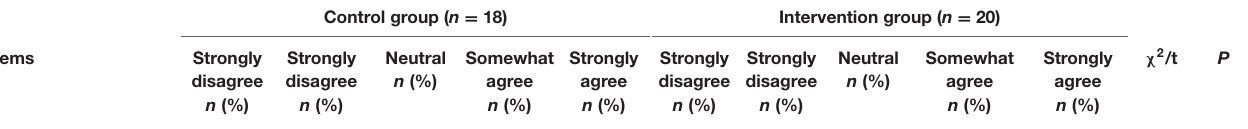
TABLE 3 | Professional identity assessment scale in the two groups.